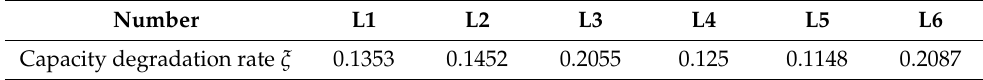
Table 6. Capacity degradation rate of L1~L6